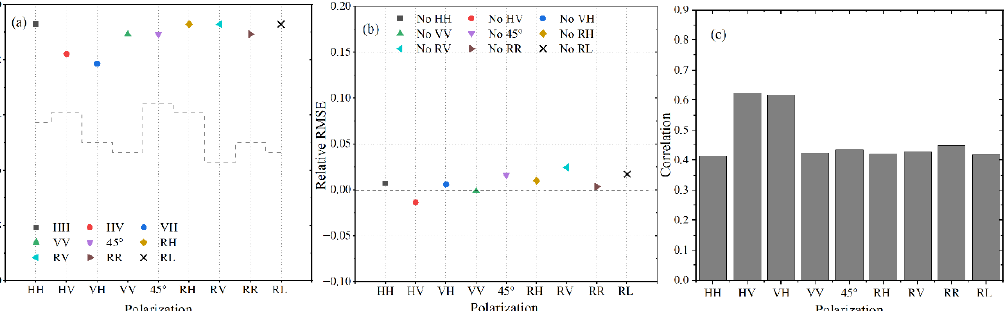
Figure 27. The importance of S 1 to SWH retrieval from single-polarization models. ( a ) The importance ranking of S 1 provided by XGBoost models normalized to 0 – 1. The dotted line represents the optimal feature sets under different polarizations. ( b ) The effect of removing S 1 on the SWH estimation from different polarized models. Different markers in various colors represent S 1 of different polarizations. ( c ) The correlation between S 1 and ERA5 SWH under different polarizations.